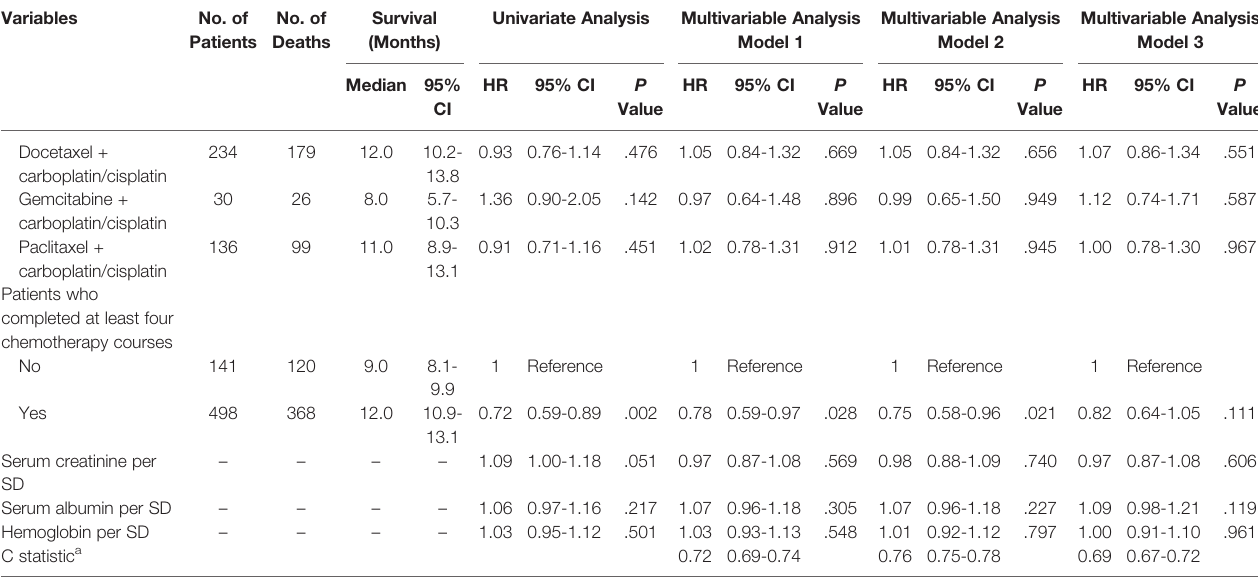
Frontiers in Oncology |